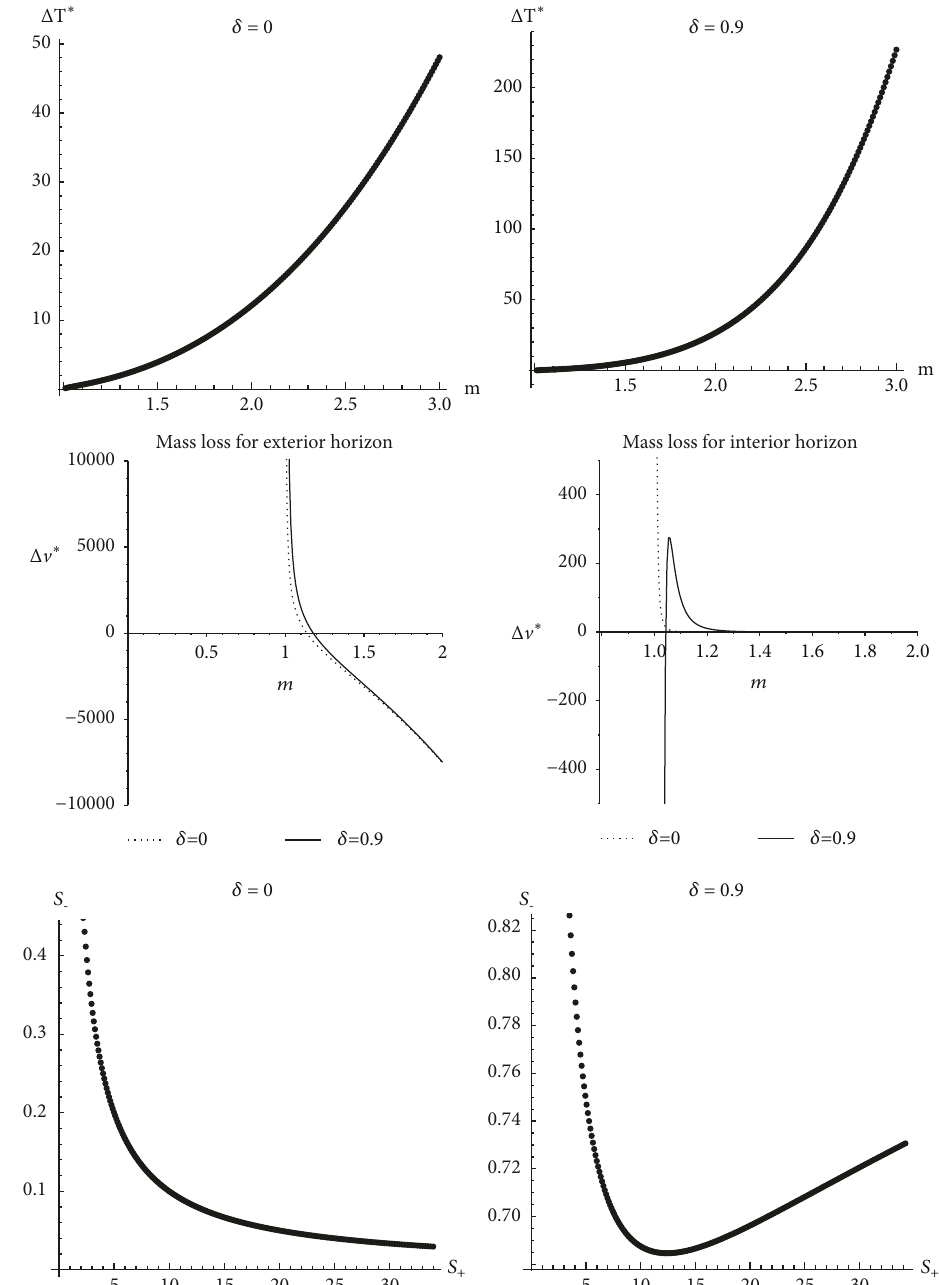
Figure 1: Diagram of mass loss 𝑚( V ) , interior (exterior) horizon entropy 𝑆 − (𝑆 + ) , and difference of temperatures between interior and exterior horizons Δ𝑇 ∗ (𝑚) is plotted against for single RNBH 𝛿 = 0 and mean metric of coarse graining RNBHs 𝛿 = 0.9 .